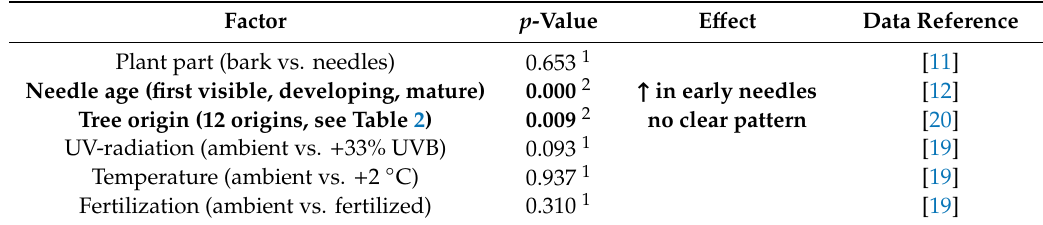
Table 1. Summary of the effect of plant part, needle age, tree origin and environmental factors on 1,6- dehydropinidine concentrations in P. abies .